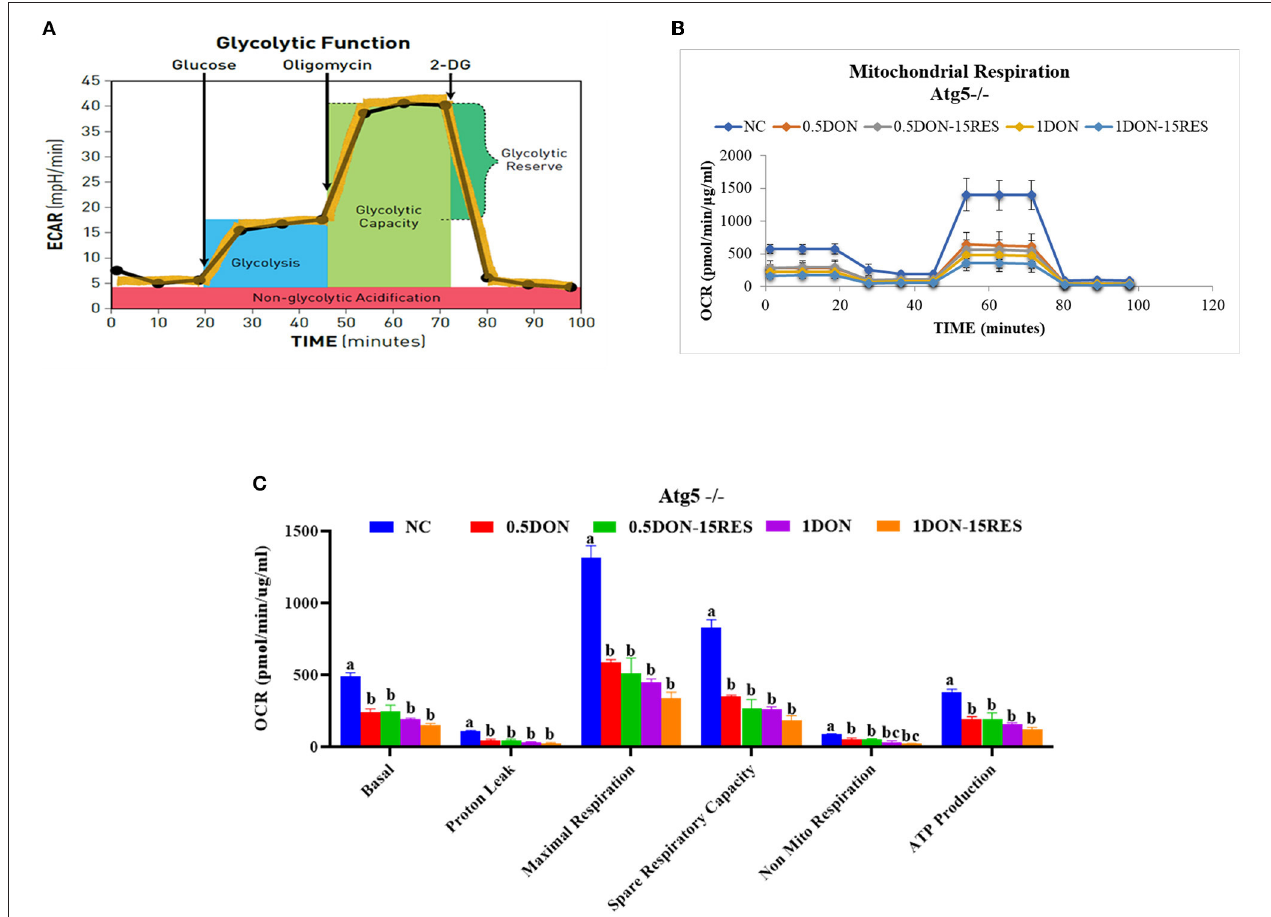
FIGURE 6 | RES did not relieve injury on mitochondrial respiration caused by DON when knockout Atg5. (A) Schematic and (B) oxygen consumption rate (OCR) assessed by extracellular flux analysis. OCR was measured under basal conditions followed by the sequential addition of oligomycin (0.5 µ M), FCCP (1 µ M), rotenone (1 µ M), or antimycin A (1 µ M). Each data point represents an OCR measurement. (C) Individual parameters for basal respiration, proton leak, maximal respiration, spare respiratory capacity, nonmitochondrial respiration, and ATP production were determined. Cells were treated with 0 (NC) or 0.5 µ mol/L or 1 µ mol/L DON and 0 or 15 µ M RES, respectively. Data were expressed as means ± SEM of at least three independent experiments. (A–C) Values with different letters are significantly different ( P <